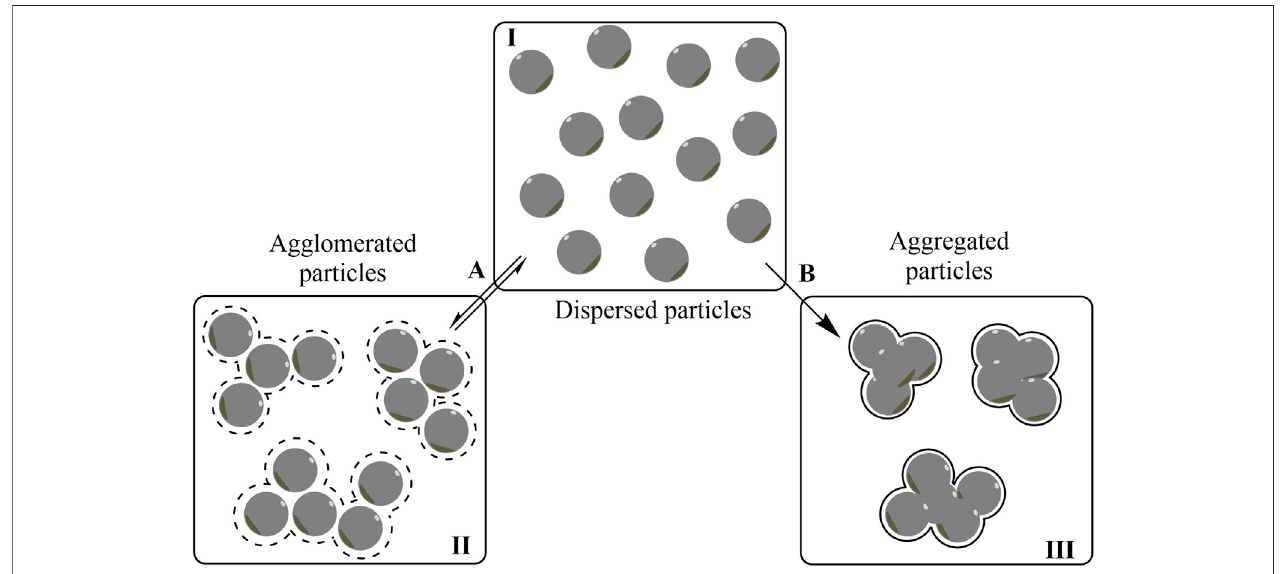
FIGURE 2 | Scheme illustrating the difference between agglomerated (II) and aggregated (III) particles. In the agglomeration process (A) , the initially dispersed particles (I) interact with each other in a reversible way by weak forces, whereas they are held tightly together by strong forces, in an irreversible way, upon aggregation (B)